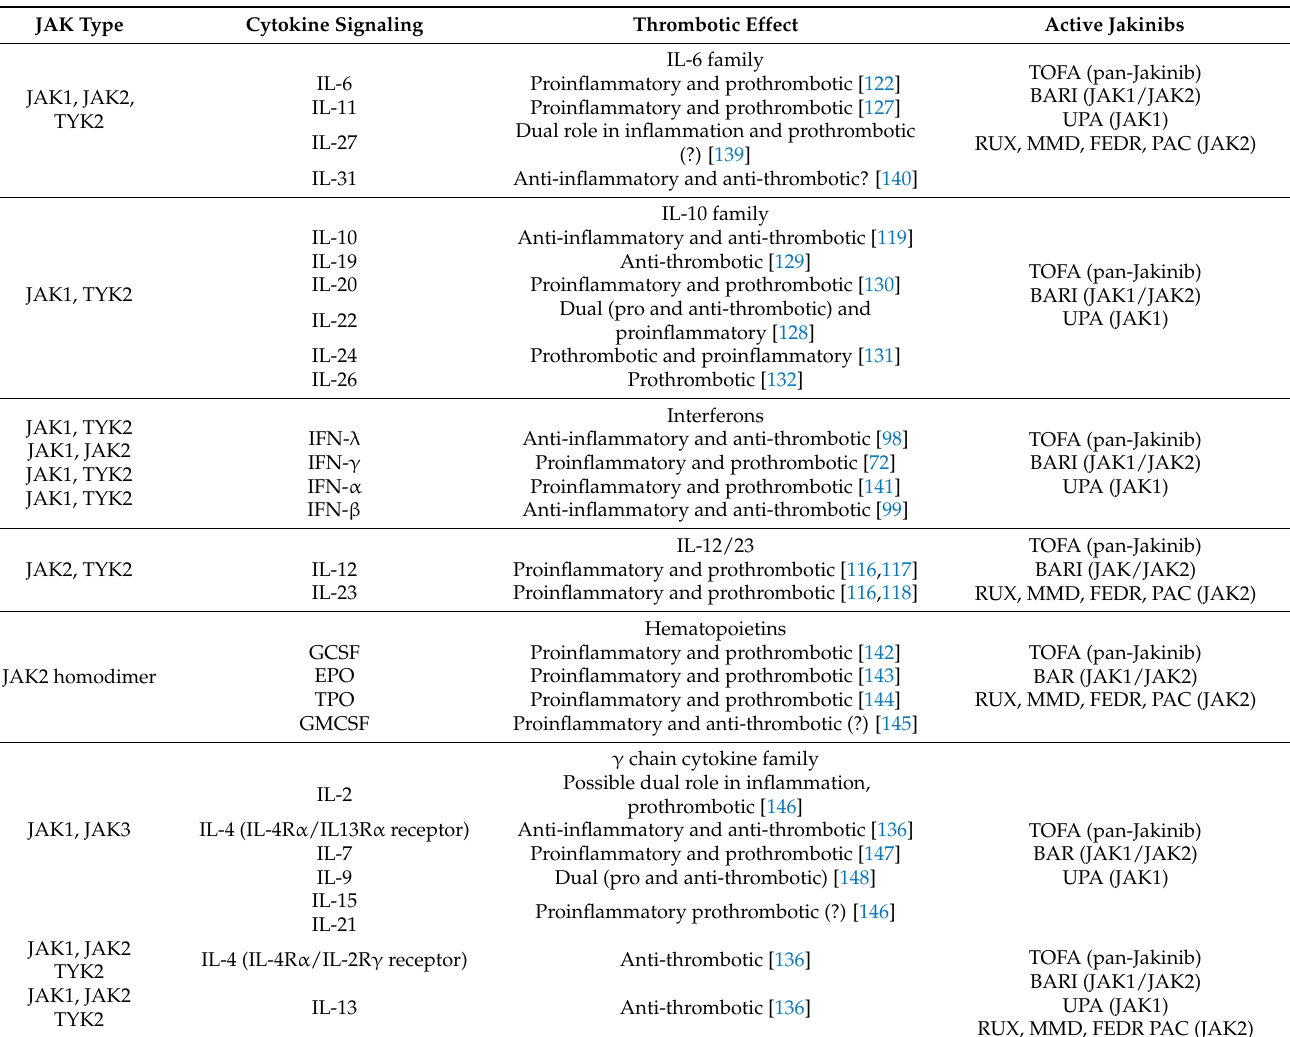
Table 2. Cytokines signaling through JAK molecules and their effect on thrombus